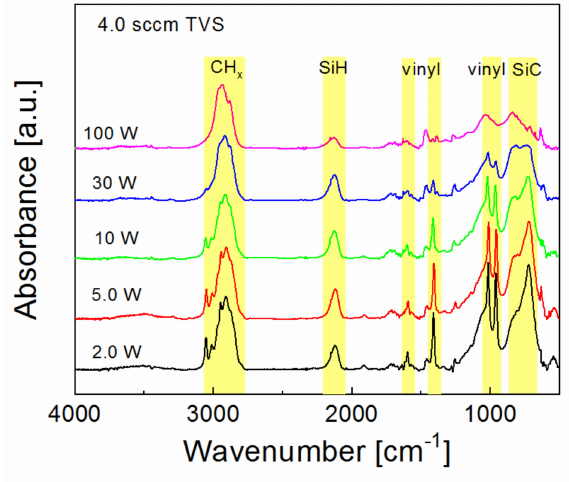
Figure 8. Infrared spectra for plasma nanocoatings deposited at di ff erent RF powers from pure TVS